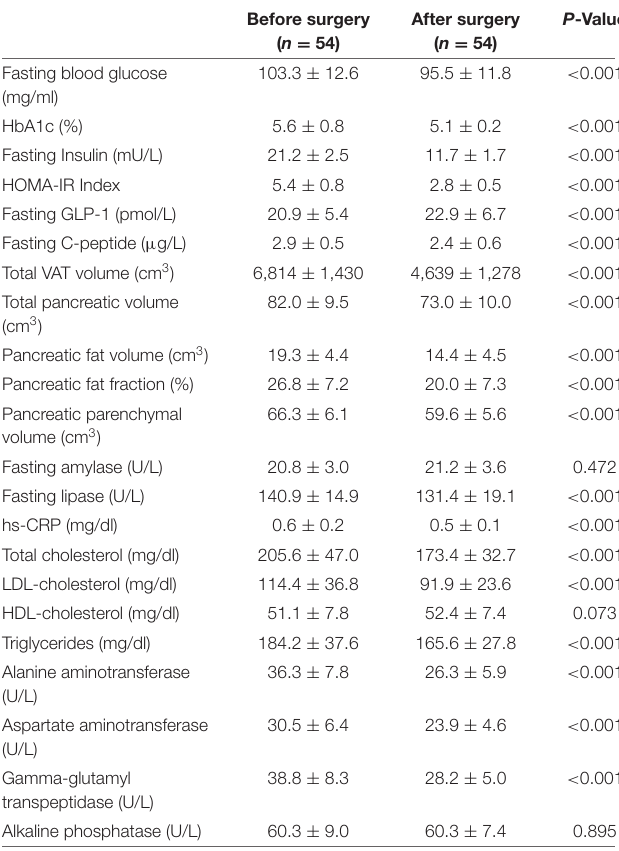
TABLE 2 | Metabolic data and laboratory parameters before and 12 months after RYGB surgery.